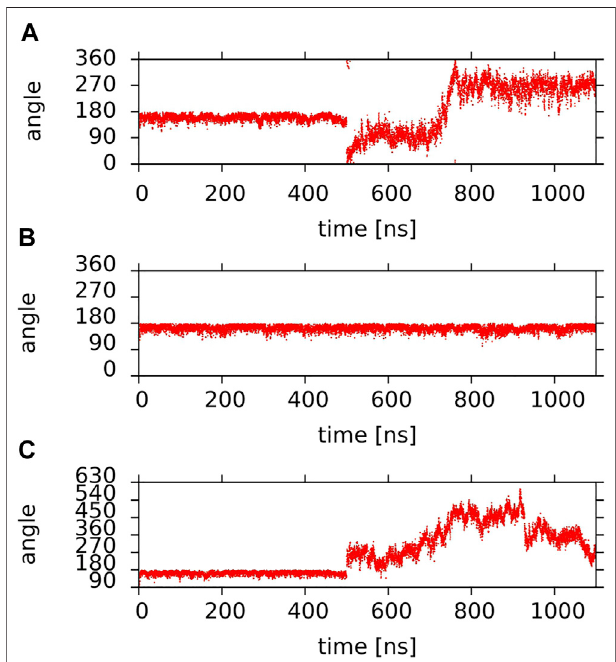
FIGURE10| Timepro fi lesofthe θ angleof (A,B) luteinmolecules (A) #4; (B) #6 in the PC-LUT_H bilayer; (C) zeaxanthin molecule #1 in the PC-ZEA_H bilayer (the y -axis scale was extended to avoid plot discontinuities due to jumps to 0 ° when 360 ° is approached). Lutein molecule #4 and zeaxanthin molecule #1 rotated to the vertical position at ∼ 500 ns of MD simulation (cf. Figure 7 and Supplementary Figure S9 ) and lutein molecule #6 remained in the horizontal position during the whole simulation